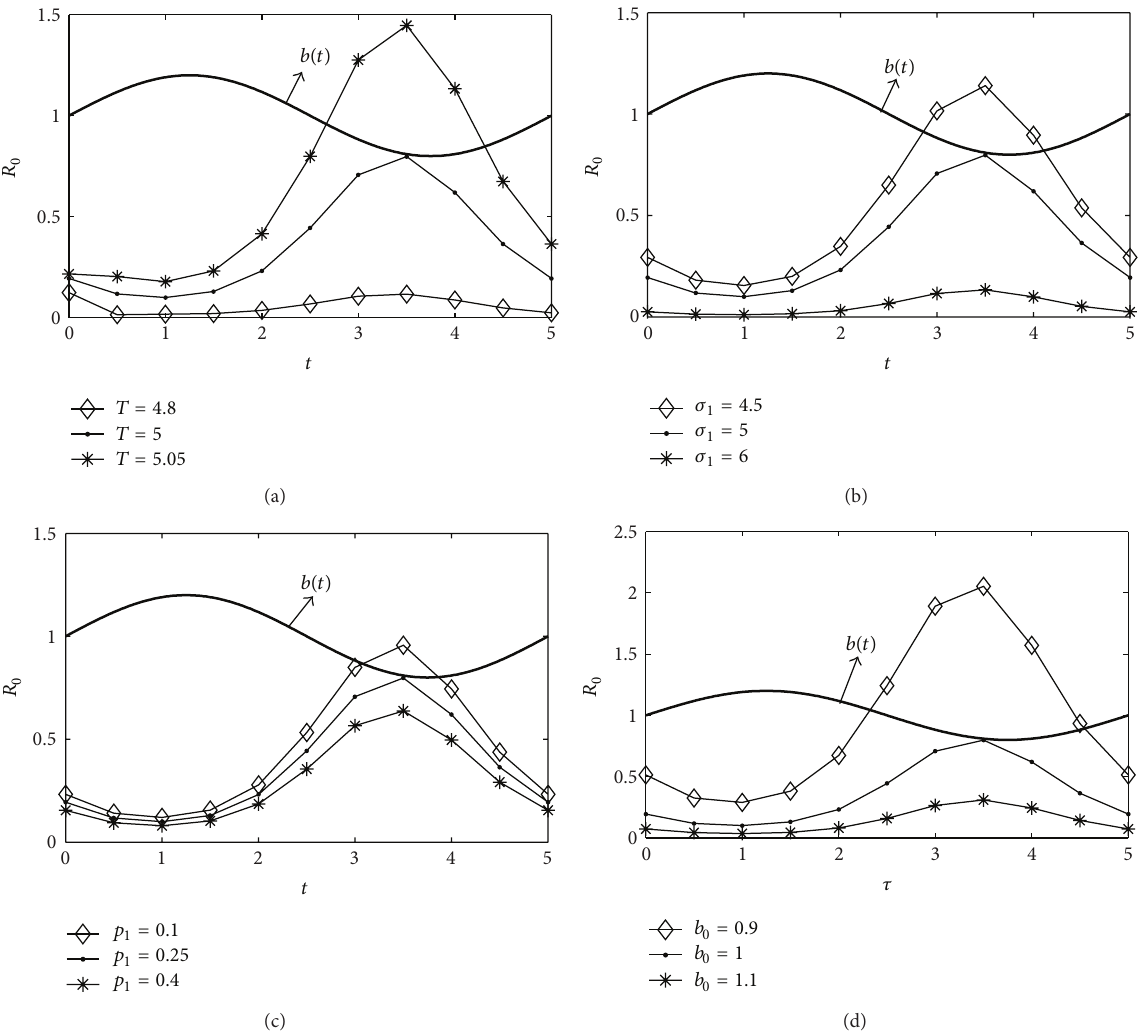
𝑟(𝑡) = 1.8 + 0.3 cos (0.4𝜋𝑡) , 𝑏(𝑡) = 1 + 0.2 sin (0.4𝜋𝑡) , 𝛿(𝑡) = 0.5 + 0.1 cos (0.4𝜋𝑡) , 𝑝 0 ; (b) the effect of the releasing quantity